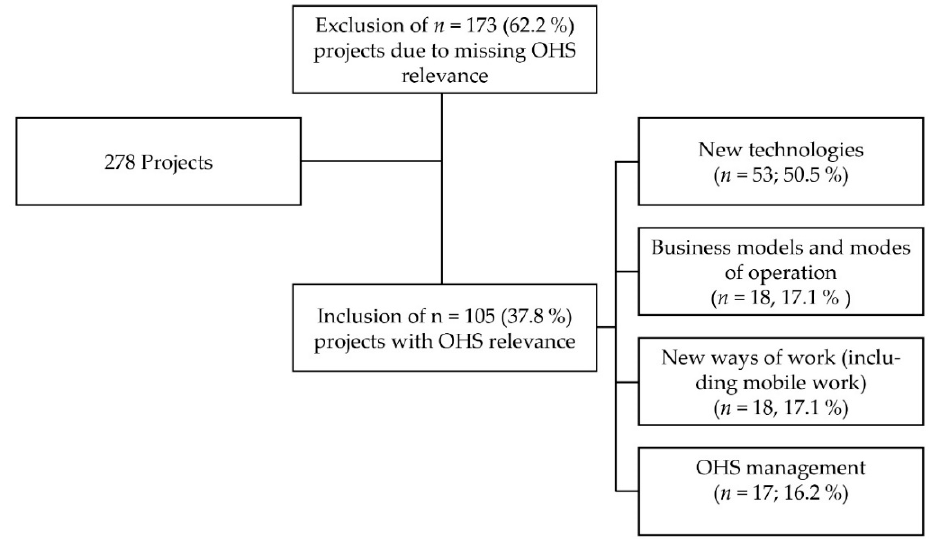
Figure 2. Flow chart of the selection process; n = 105 projects were included in the analysis.